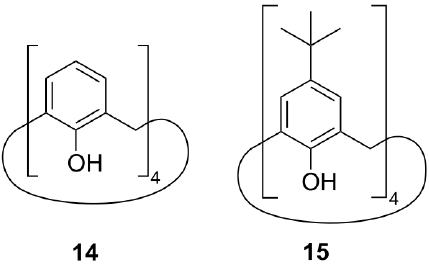
Figure 7. Structures of calix[4]arene ( 14 ) and 4-t- butylcalix[4]arene ( 15